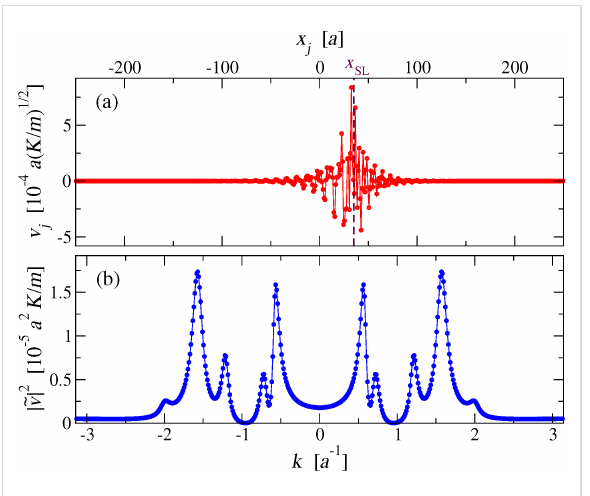
Figure 8: The square modulus of the Fourier transforms of the veloci- ties v j ( t ), at six subsequent times. Here the slider velocity is v SL = 0.1 v s . Comparing the plots of and , one sees that repeats itself identically after one entire period T = a / v SL = 10 ( m / K ) 1 / 2 . To obtain a time-independent description of the typical phonon- excitation spectrum at a given v SL , we average the square modulus of over a period T . We select M = 50